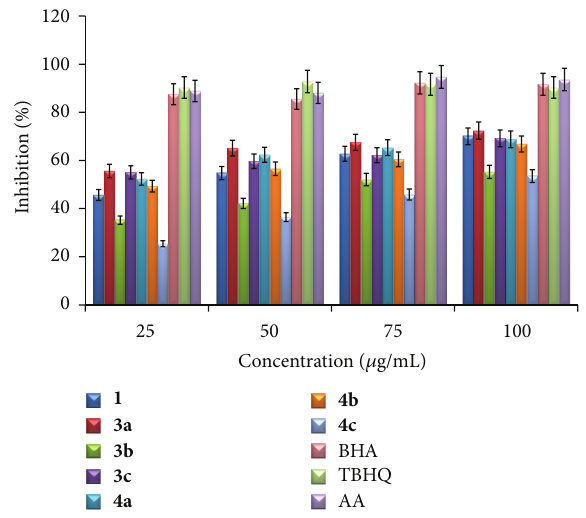
Figure 1: RSA of the compounds ( 1 and 3-4